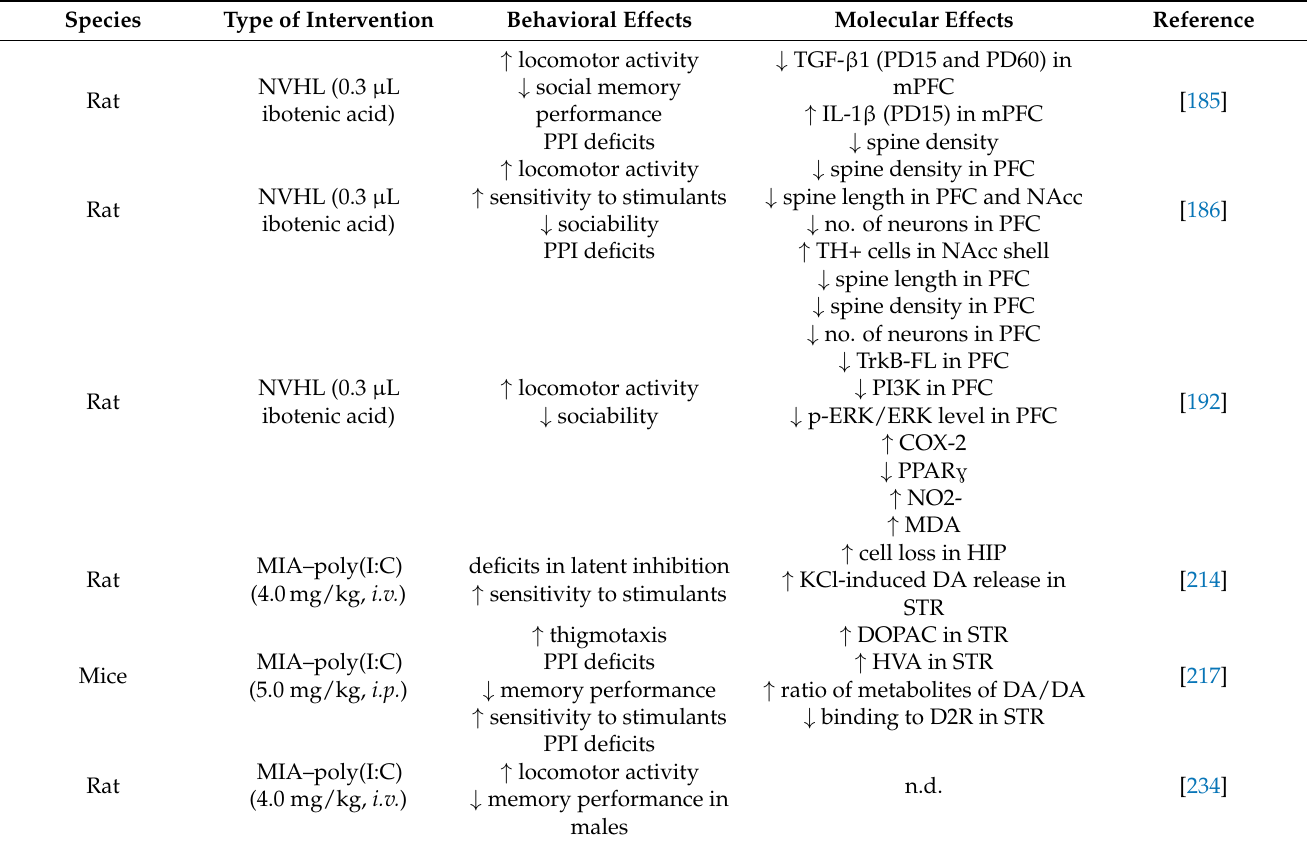
Table 3. Several examples of developmental interventions used to model schizophrenia and its behavioral and molecular